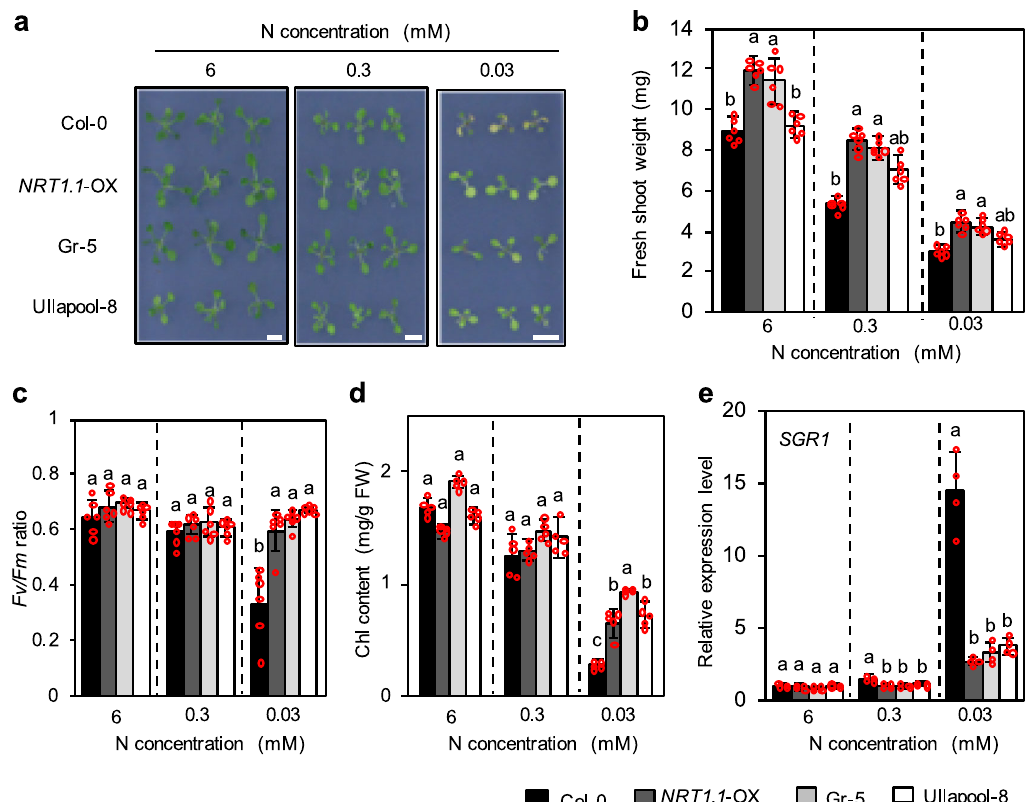
Fig. 3 Characterization of the growth of Gr-5 and Ullapool-8 plants under low N conditions. a – e Visible phenotype ( a ), fresh shoot weight ( b ), Fv/Fm ratios ( c ), total chlorophyll contents ( d ) and SGR1 expression levels ( e ) of Col-0, NRT1.1 overexpression line 1 ( NRT1.1 -OX; Col-0 background), Gr-5, and Ullapool-8 seedlings. Seedlings were grown with continuous light for 5 days on 1/2 MS agar plates and then for 5 days on modi fi ed 1/2 MS agar plates that contained 6 mM N (control) or with 0.3 or 0.03 mM N (low N treatment). Chlorophyll contents and SGR1 levels were quanti fi ed in the shoots. Data represent mean ± SD of more than four biological replicates. a Scale bar = 1 cm. b – e Different lowercase letters indicate signi fi cant differences ( p < 0.05; ANOVA followed by Tukey ’ s post-hoc comparison